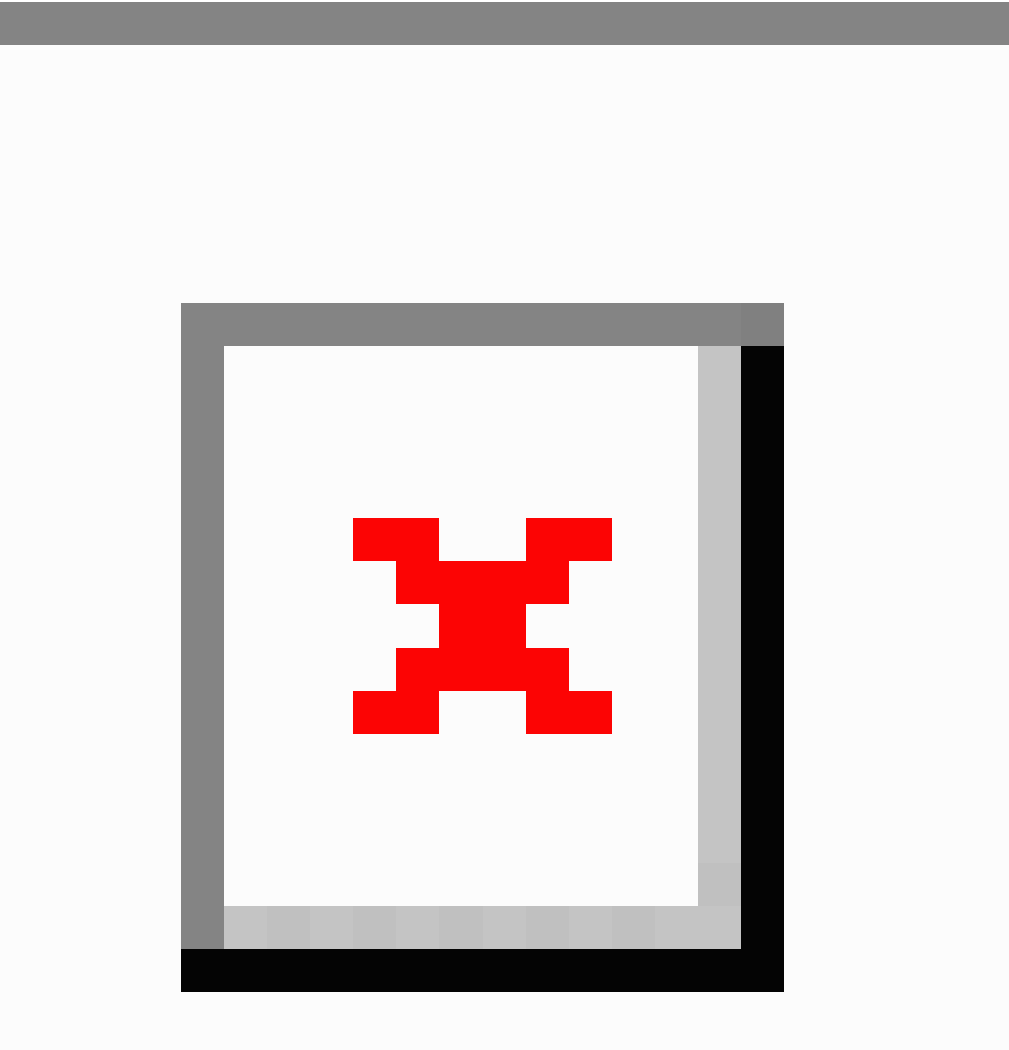
Figure 2. Boxplots of all data collected in comparable SOT (light) and VR (dark) conditions. The median value (thick line), IQR (box edges), and 95% CI (whiskers) are indicated. SOT: sensory organization test; VR: virtual